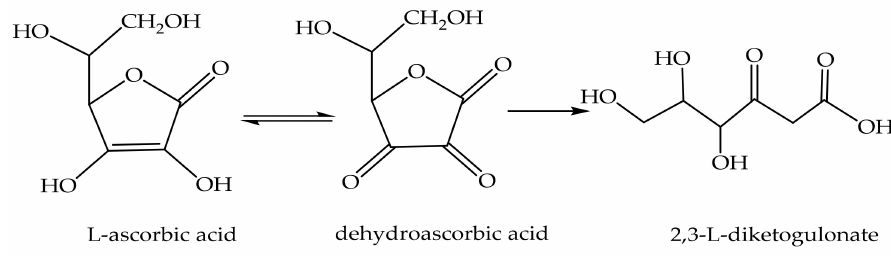
Figure 1. Ascorbic acid oxidation reaction.